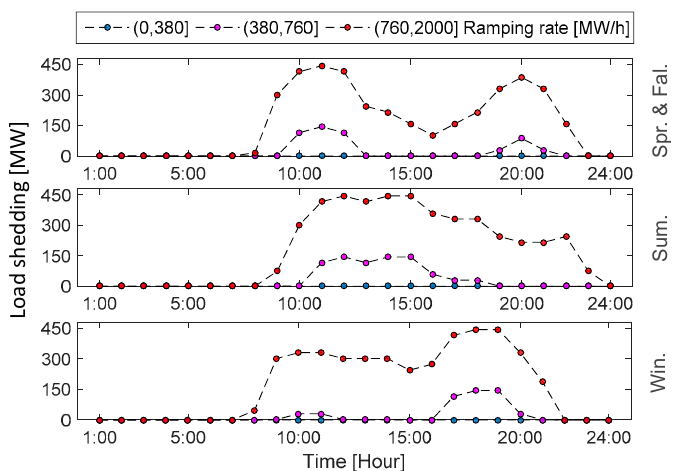
Figure 8. Distribution of load shedding caused by wind power ramping events (WPRs).